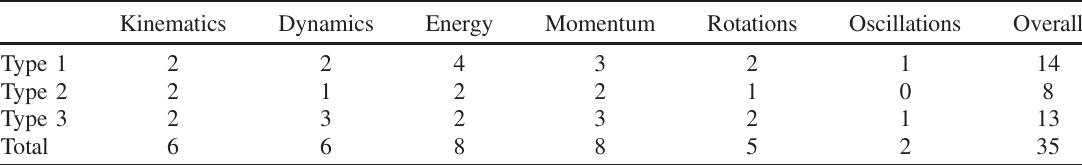
TABLE I. The number of coaches for each topic and the types of coaches available for each topic.